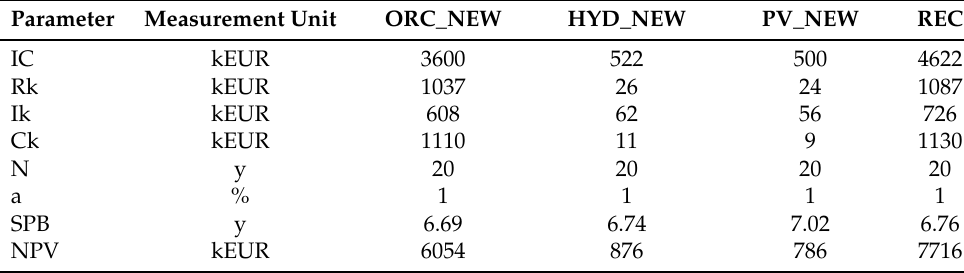
Table 12. Economic data for each technology and the REC proposed for Tirano